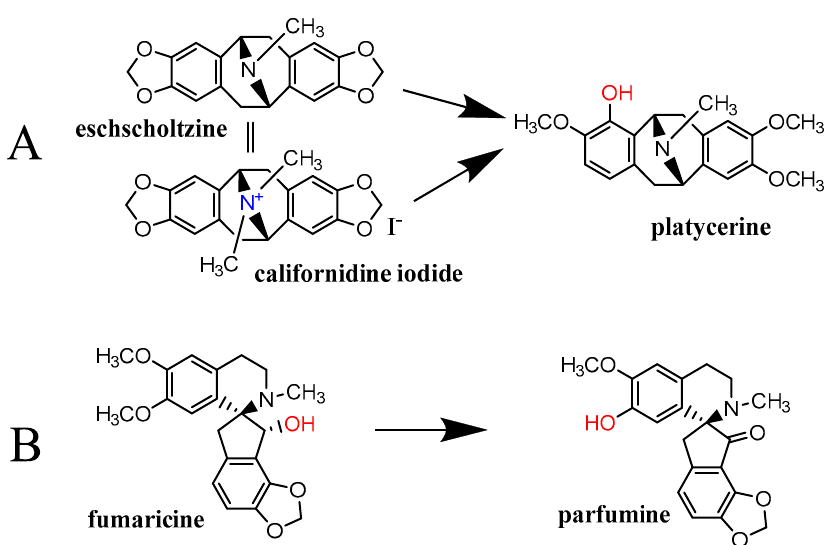
Figure 7. Graphical depiction of cupric-reduction potencies of tested pavinane alkaloids ( A ) and spirobenzylisoquinolines ( B ). Arrows point to stronger reduction compounds.